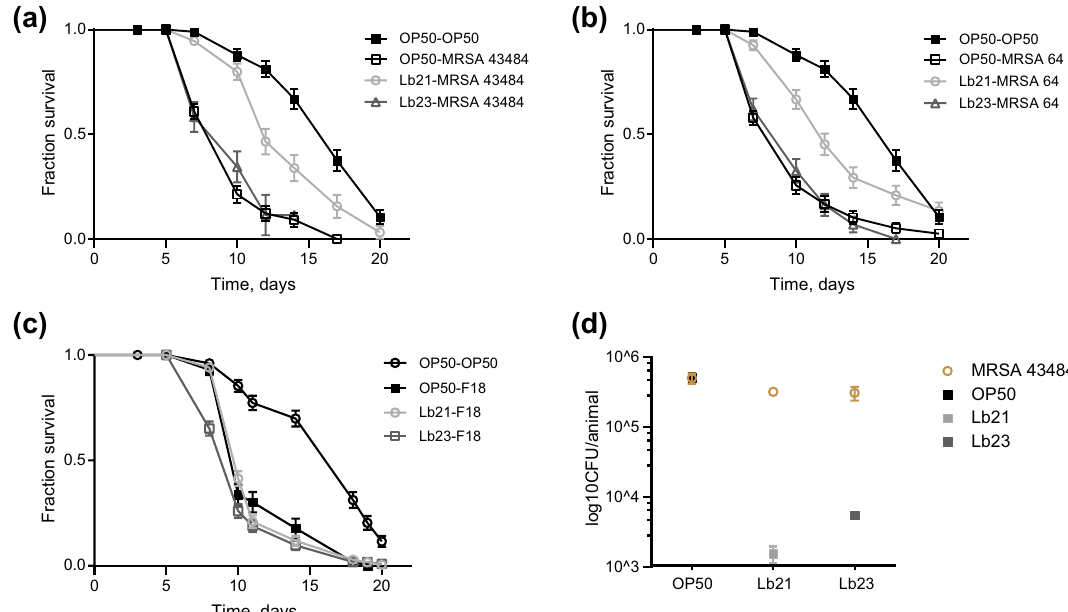
Figure 2. Lb21 but not Lb23 increases MRSA tolerance in C. elegans . ( a ) Survival of rrf-3(pk1426) mutants pretreated with Lb21, Lb23 and OP50 for 48 h before being shifted to MRSA strain 43484. ( b ) Survival of rrf-3(pk1426) mutants pretreated with Lb21, Lb23 and OP50 for 48 h before being shifted to MRSA strain 64. ( c ) Survival of rrf-3(pk1426) mutants after pretreatment with Lb21, Lb23 and OP50 for 48 h before being challenged with the pathogen ETEC F18. Graphs show a representative experiment from several independent experiments. See Table S1 for mean ± SD and log-rank test significance. ( d ) CFU level on day 6 of Lb21, Lb23 or OP50 and MRSA 43484 in rrf-3(pk1426) mutants pretreated for 48 h with Lb21, LB23 or OP50, respectively (3 technical replicates, n = 10 animals pr.